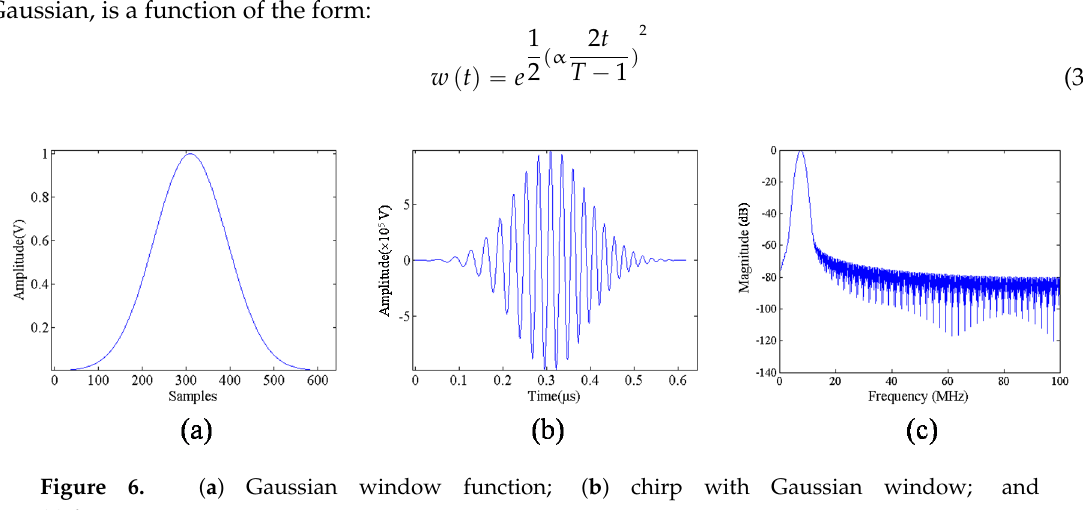
Figure 6. ( a ) Gaussian window function; ( b ) chirp with Gaussian window; and ( c ) frequency responses.